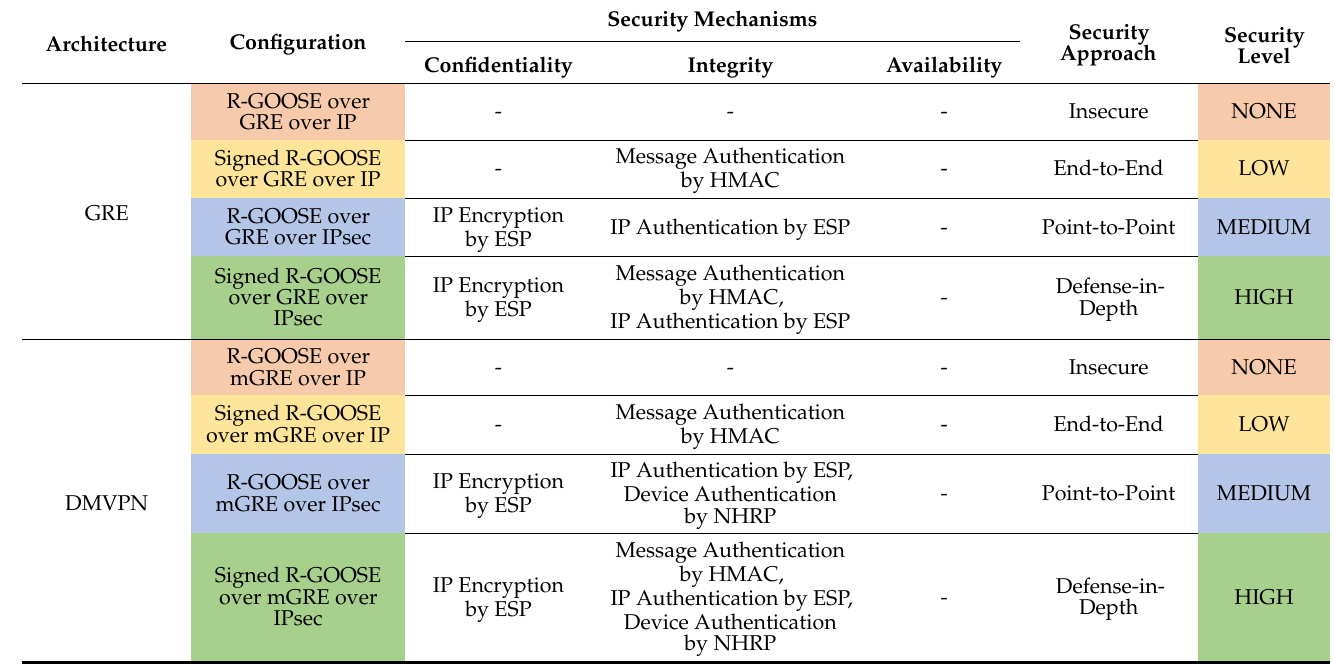
Table 7. Communication security level of the proposed